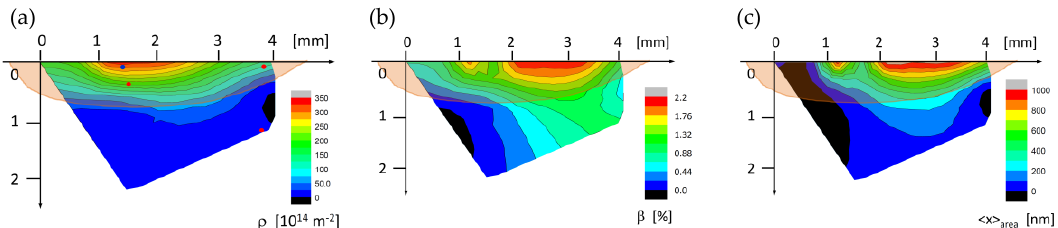
Figure 9. Measured (open circles) and CMWP-calculated (red lines) diffraction patterns ( a ), ( c ), ( e ), and ( g ) in the entire, and ( b ), ( d ), ( f ), and ( h ) in a zoomed angular range at four different depths in the ZrH blister. ( a ) and ( b ) are along Line-1 Run-1 at the top right edge, ( c ) and ( d ) are along Line-1 Run- 8 at the center, ( e ) and ( f ) are along Line-2 Run-11 at the lower center edge, and ( g ) and ( h ) are along Line-3 Run-3 at the right middle edge of the blister,